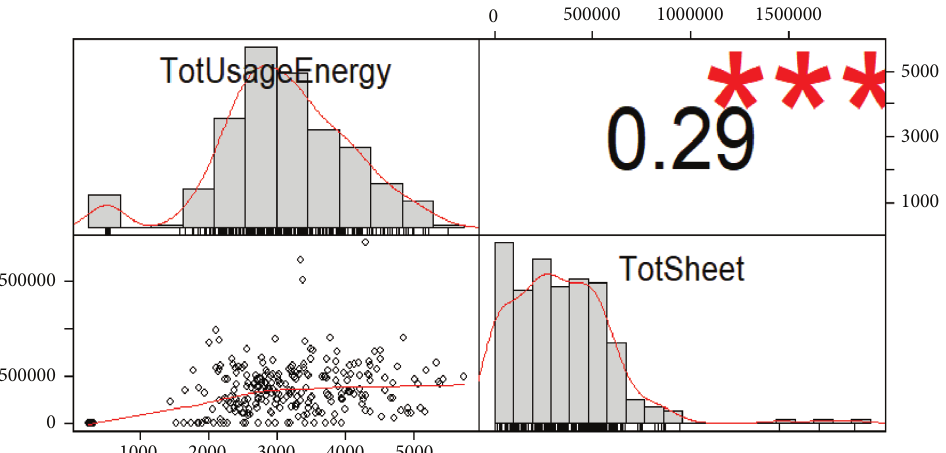
Figure 11: Diagram showing correlations values of total usages of energy and total sheet productions.